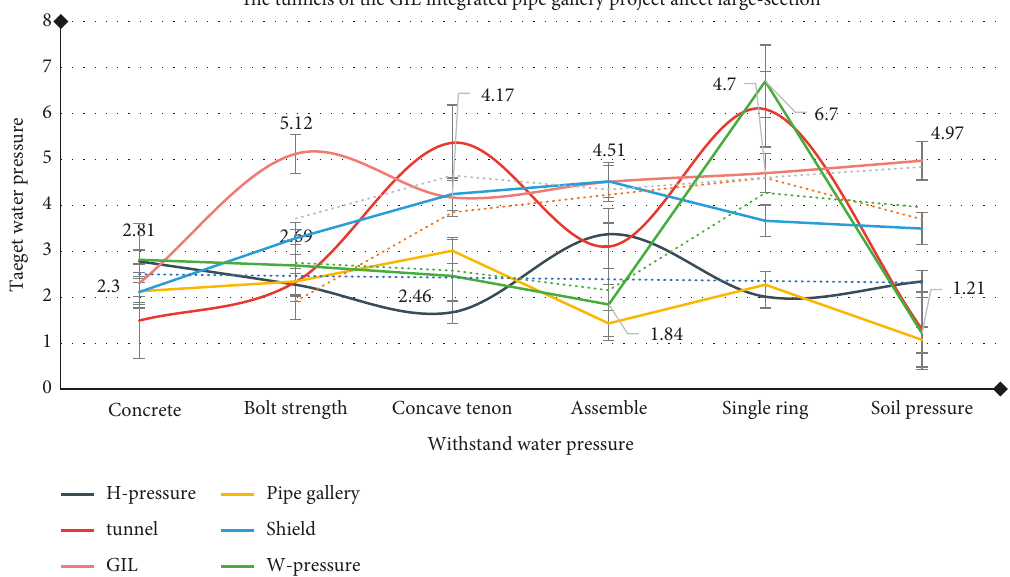
Figure 1: The tunnels of the GIL integrated pipe gallery project affect